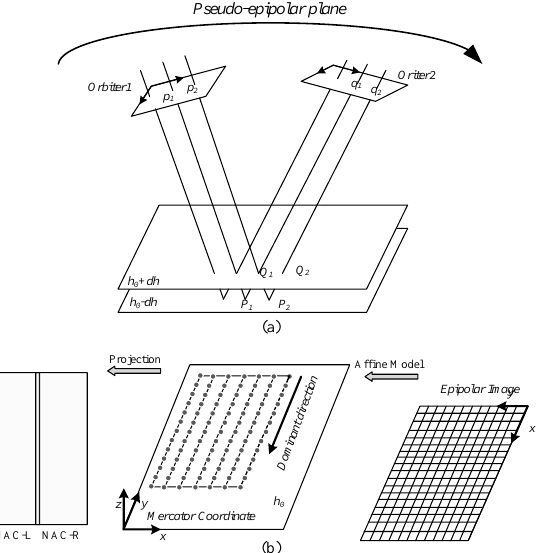
Figure 3. Illustration of the coupled epipolar rectification. (a) Determination of the epipolar curve by iteratively projection and back-projection in the pseudo-epipolar plane; and (b) affine resample of the epipolar